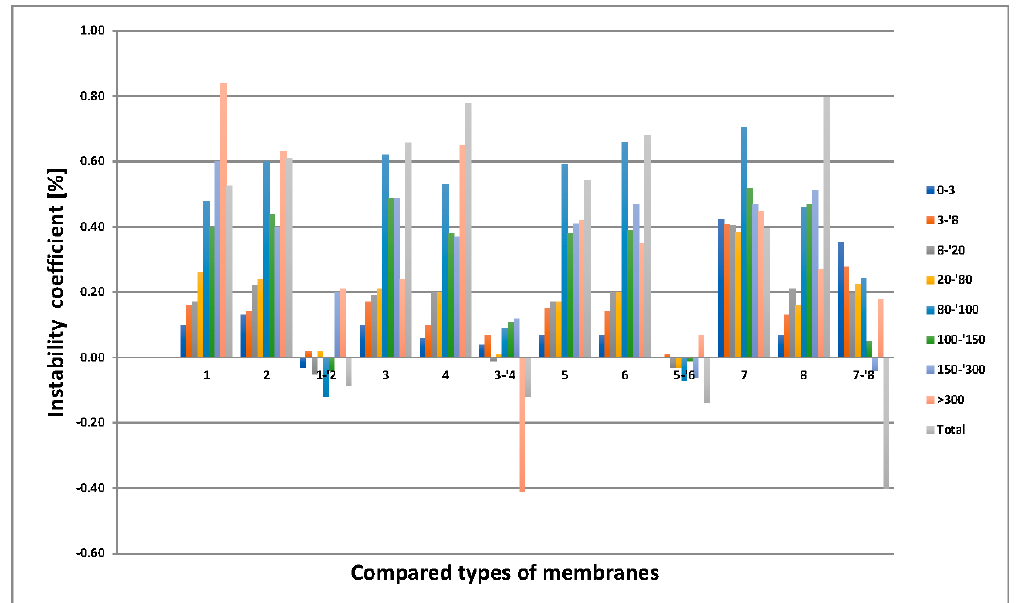
Figure 11. Influence of the using a solvent on the instability of membranes’ porosity in different types and size-classes of pores.